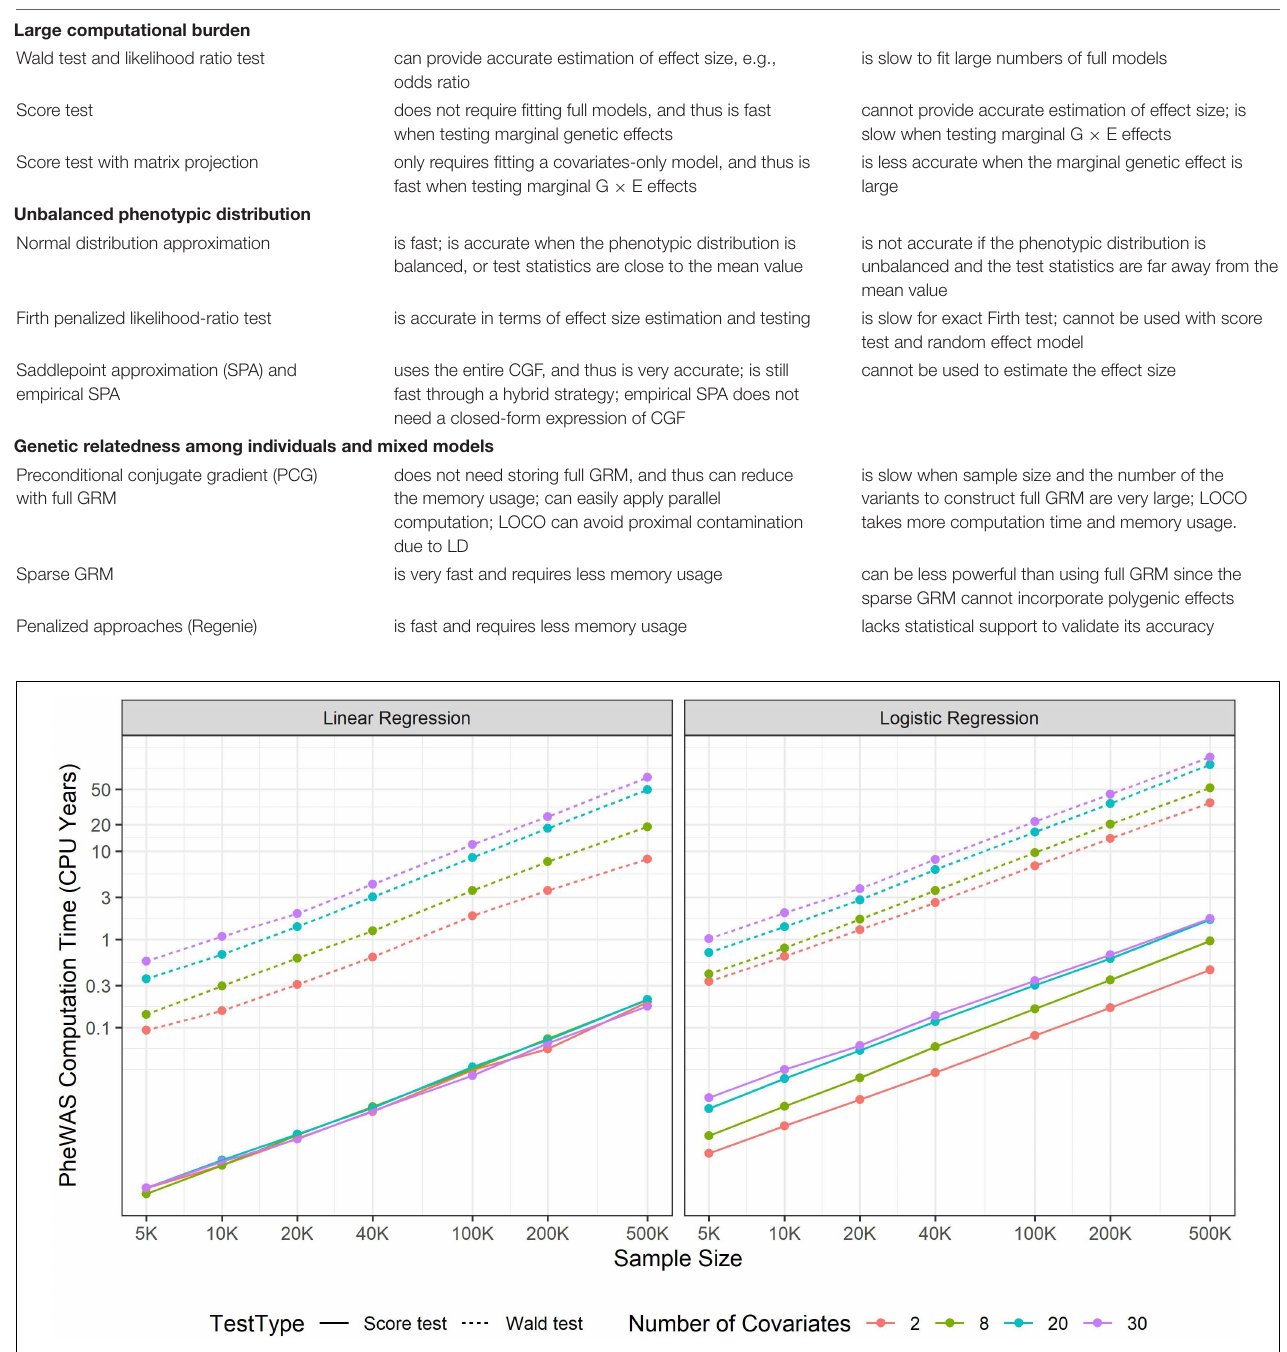
FIGURE 1 | PheWAS computation time. The computation time is evaluated at CPU core of Intel i7-7700T 2.90GHz and then projected to a phenome-wide association studies including 100 balanced binary phenotypes and 10 million